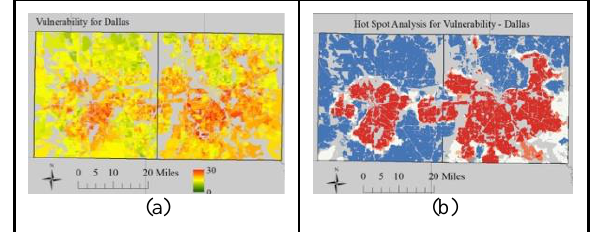
Figure 7. Socio-economic vulnerability map and hot spot analysis for Dallas and Tarrant Counties